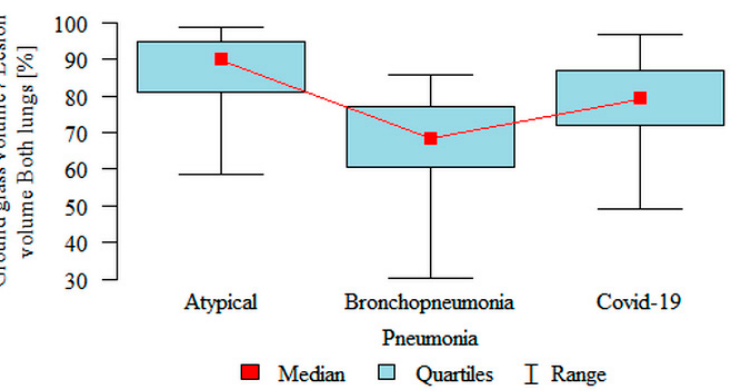
Figure 6. Comparison of the volume of “ground glass” as a percentage of the volume of inflammation (“lesion”) in both lungs, in three subgroups of pneumonia.